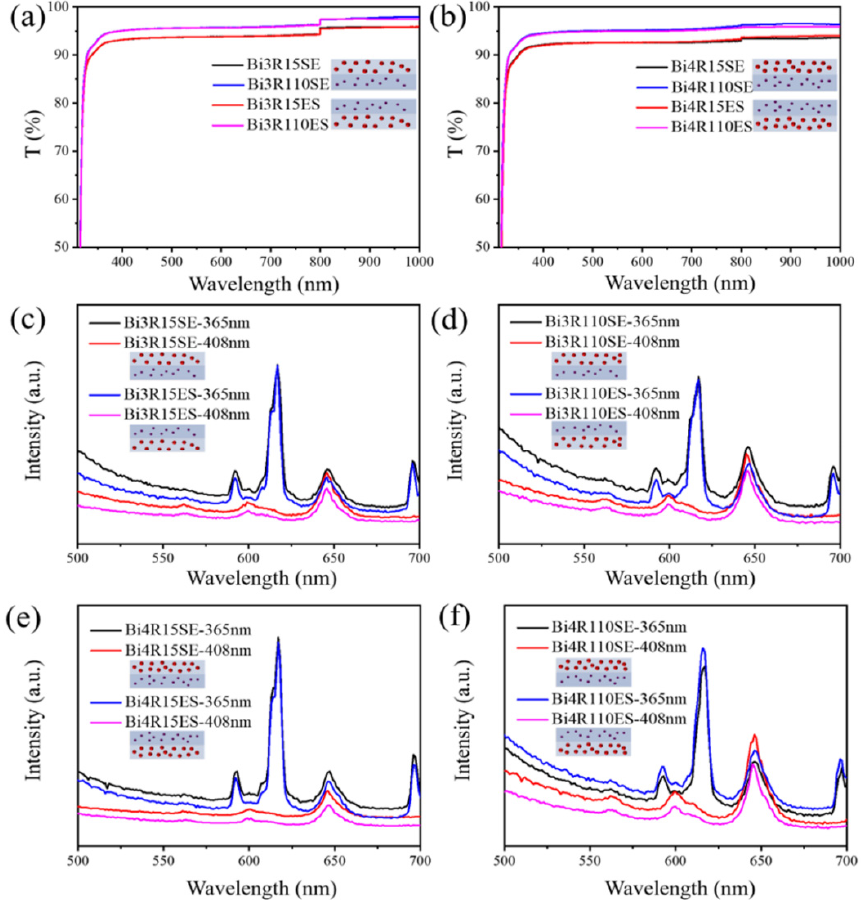
Figure 10. ( a , b ) Transmission spectrum of the bilayer coatings. ( c ) Emission spectra of Bi3R15SE and Bi3R15ES upon the excitation at 365 and 408 nm, respectively. ( d ) Emission spectra of Bi3R110SE and Bi3R110ES. ( e ) Emission spectra of Bi4R15SE and Bi3R15ES. ( f ) Emission spectra of Bi4R110SE and Bi4R110ES.